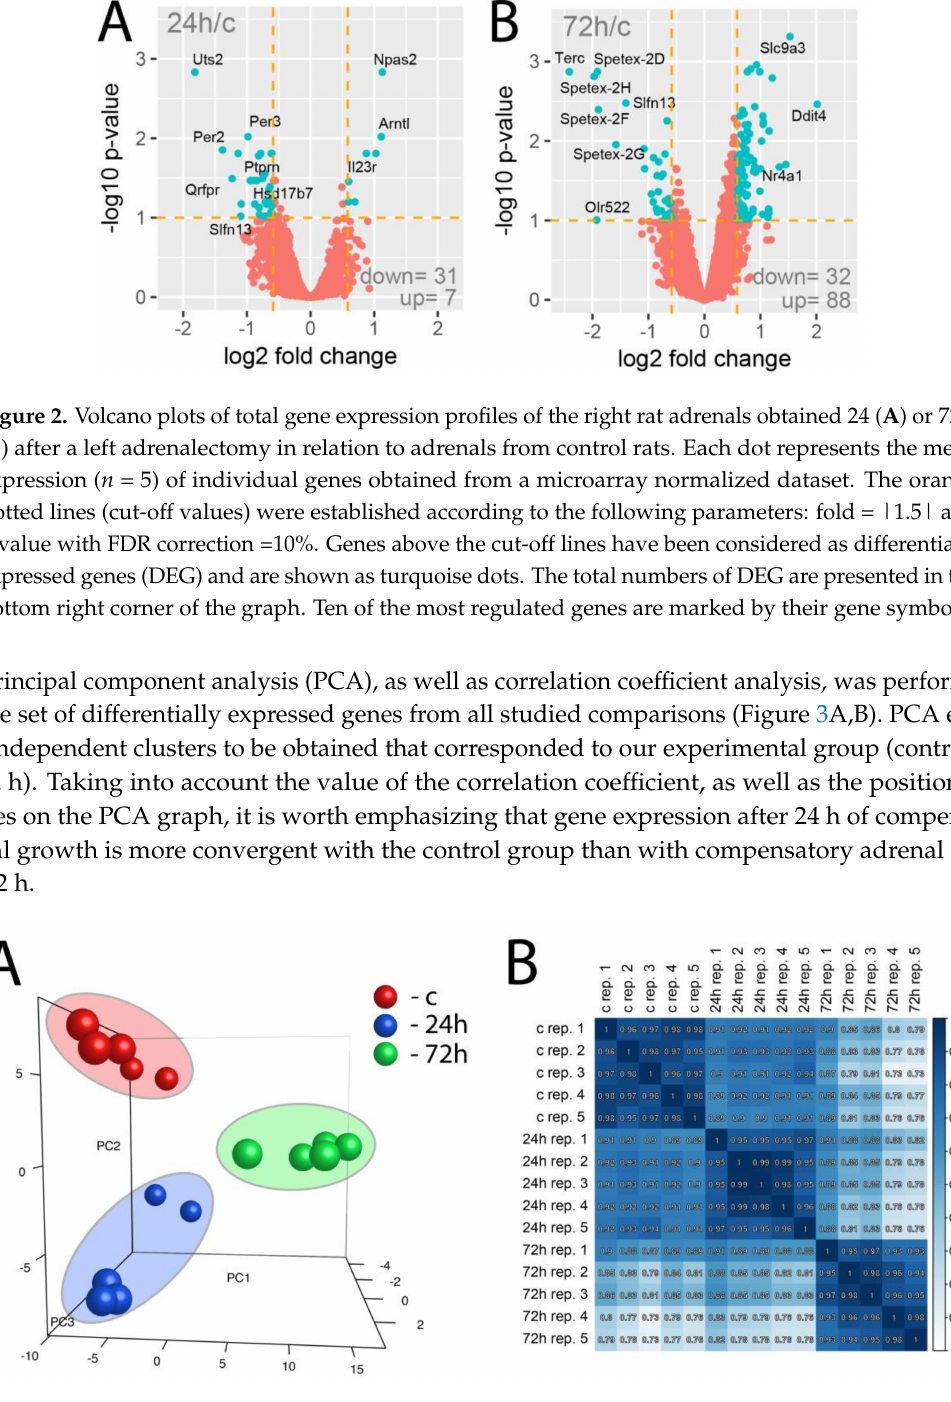
Figure 3. Principal component analysis (PCA) graph of a whole set of differentially expressed genes from all studied comparisons (24 h/c and 72 h/c) ( A ). Each dot represents one of the experimental sample assigned to the appropriate experimental group. (PC1: principal component 1; PC2: principal component 2; PC3: principal component 3). Pearson’s correlation coefficient analysis array ( B ). The correlation coefficient was calculated for all experimental